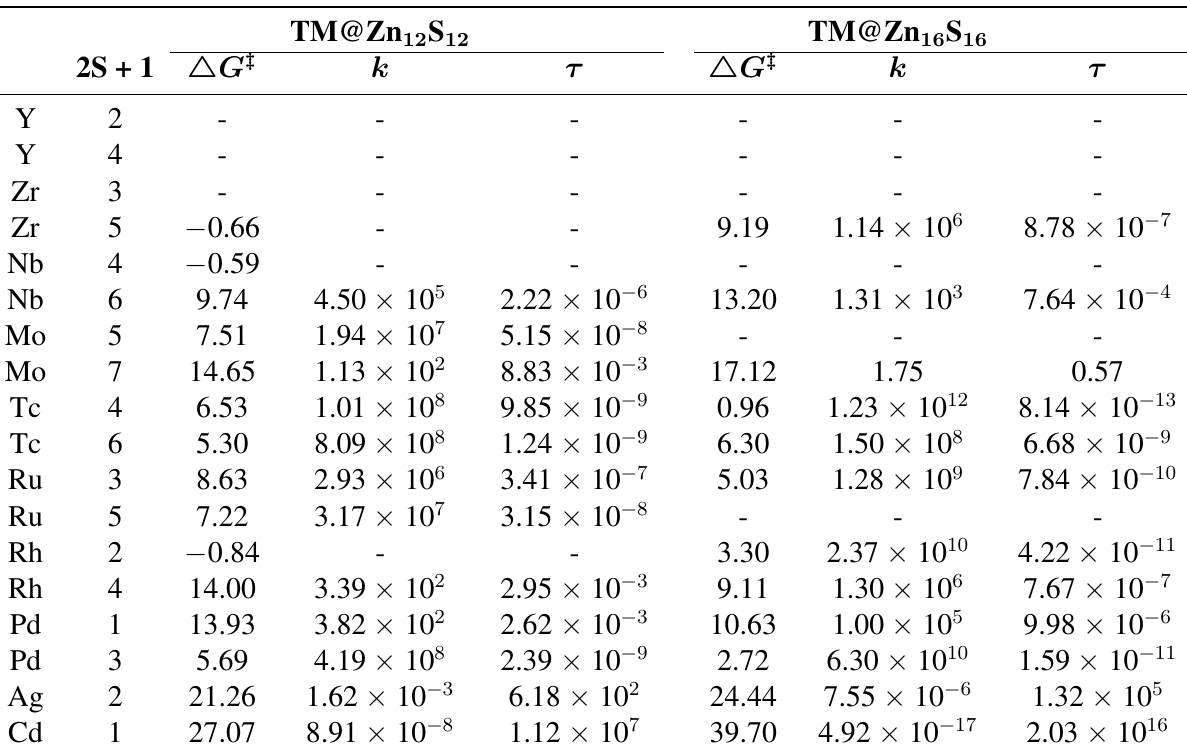
Table 3. Characterized transition states between endohedral compounds and surface compounds for TM@Zn S and TM@Zn S . (cid:52) G (kcal/mol) is the energy 12 12 16 16 TS − end difference between the TS and the endohedral structure, k (s − 1 ) stands for the calculated reaction rate constant and and τ (s) are the calculated lifetimes of the endohedral